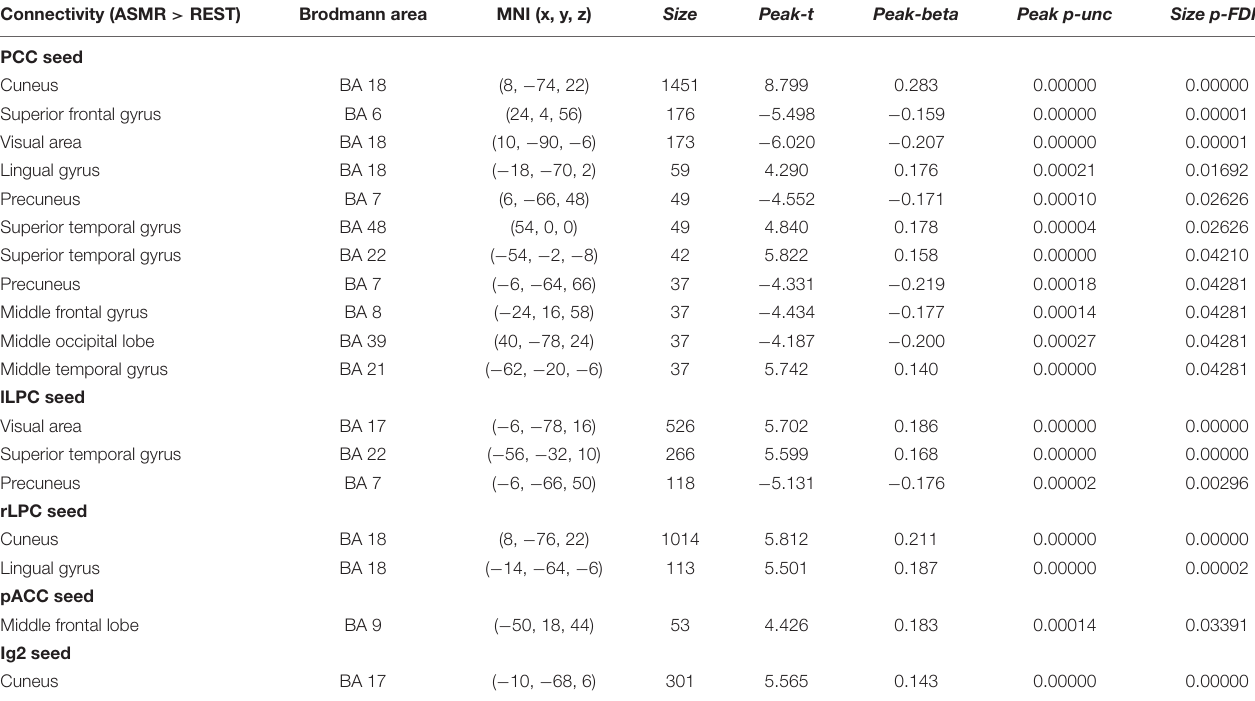
TABLE 3 | Statistical significance of the group-level functional connectivity obtained by the “ASMR > resting-state” contrast. Connectivity (ASMR > REST)